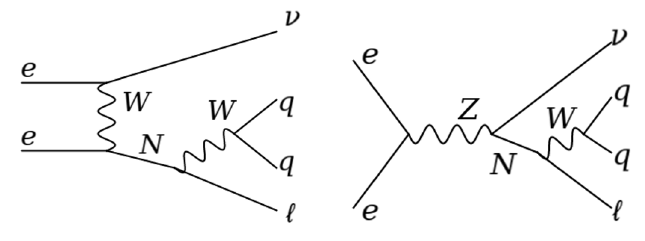
Figure 2. Feynman diagrams for heavy neutrino production at e + e − colliders with the qq‘ν signa-